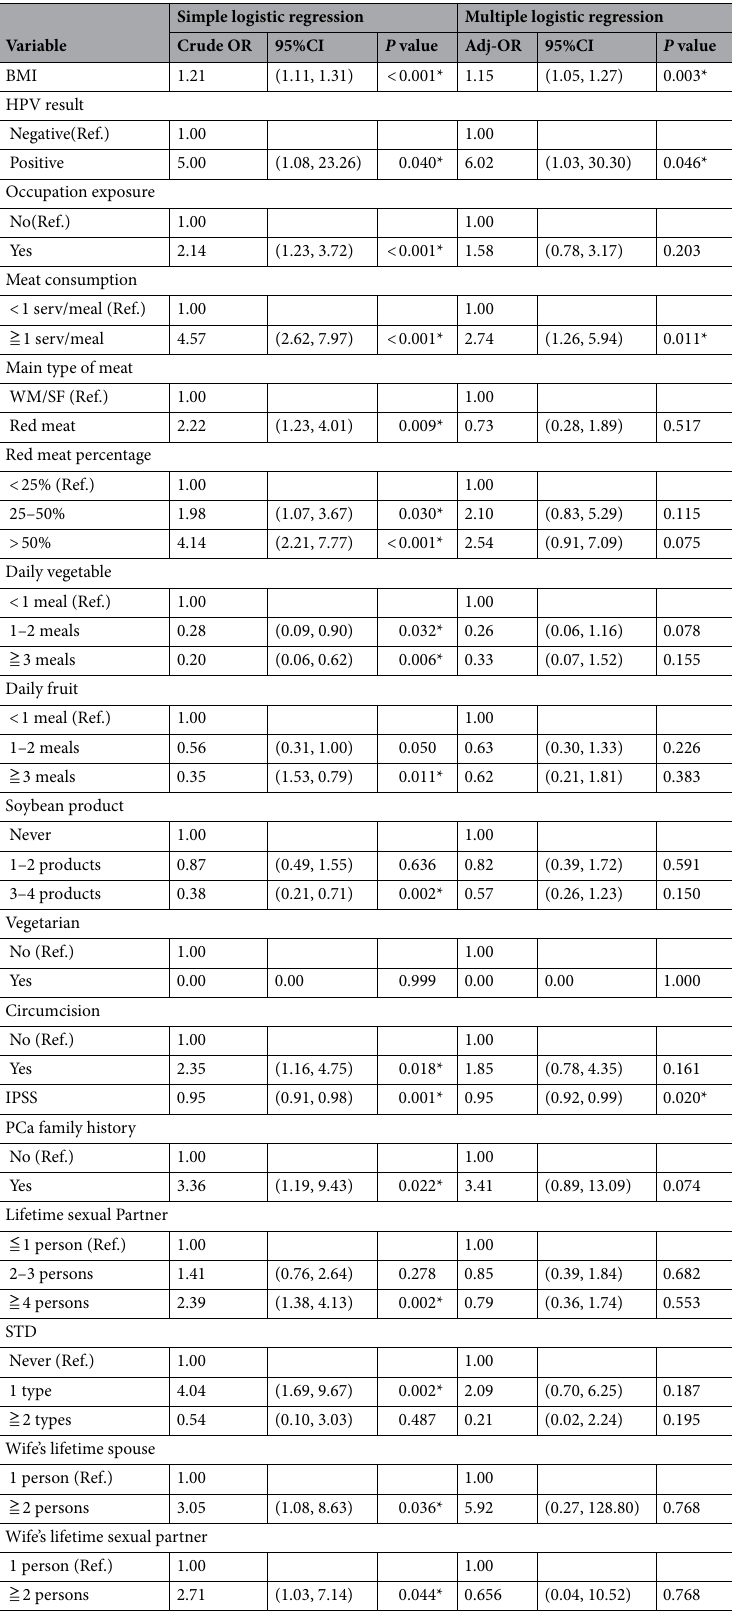
Table 3. Logistic regression analysis of risk factors associated with PCa. * P <